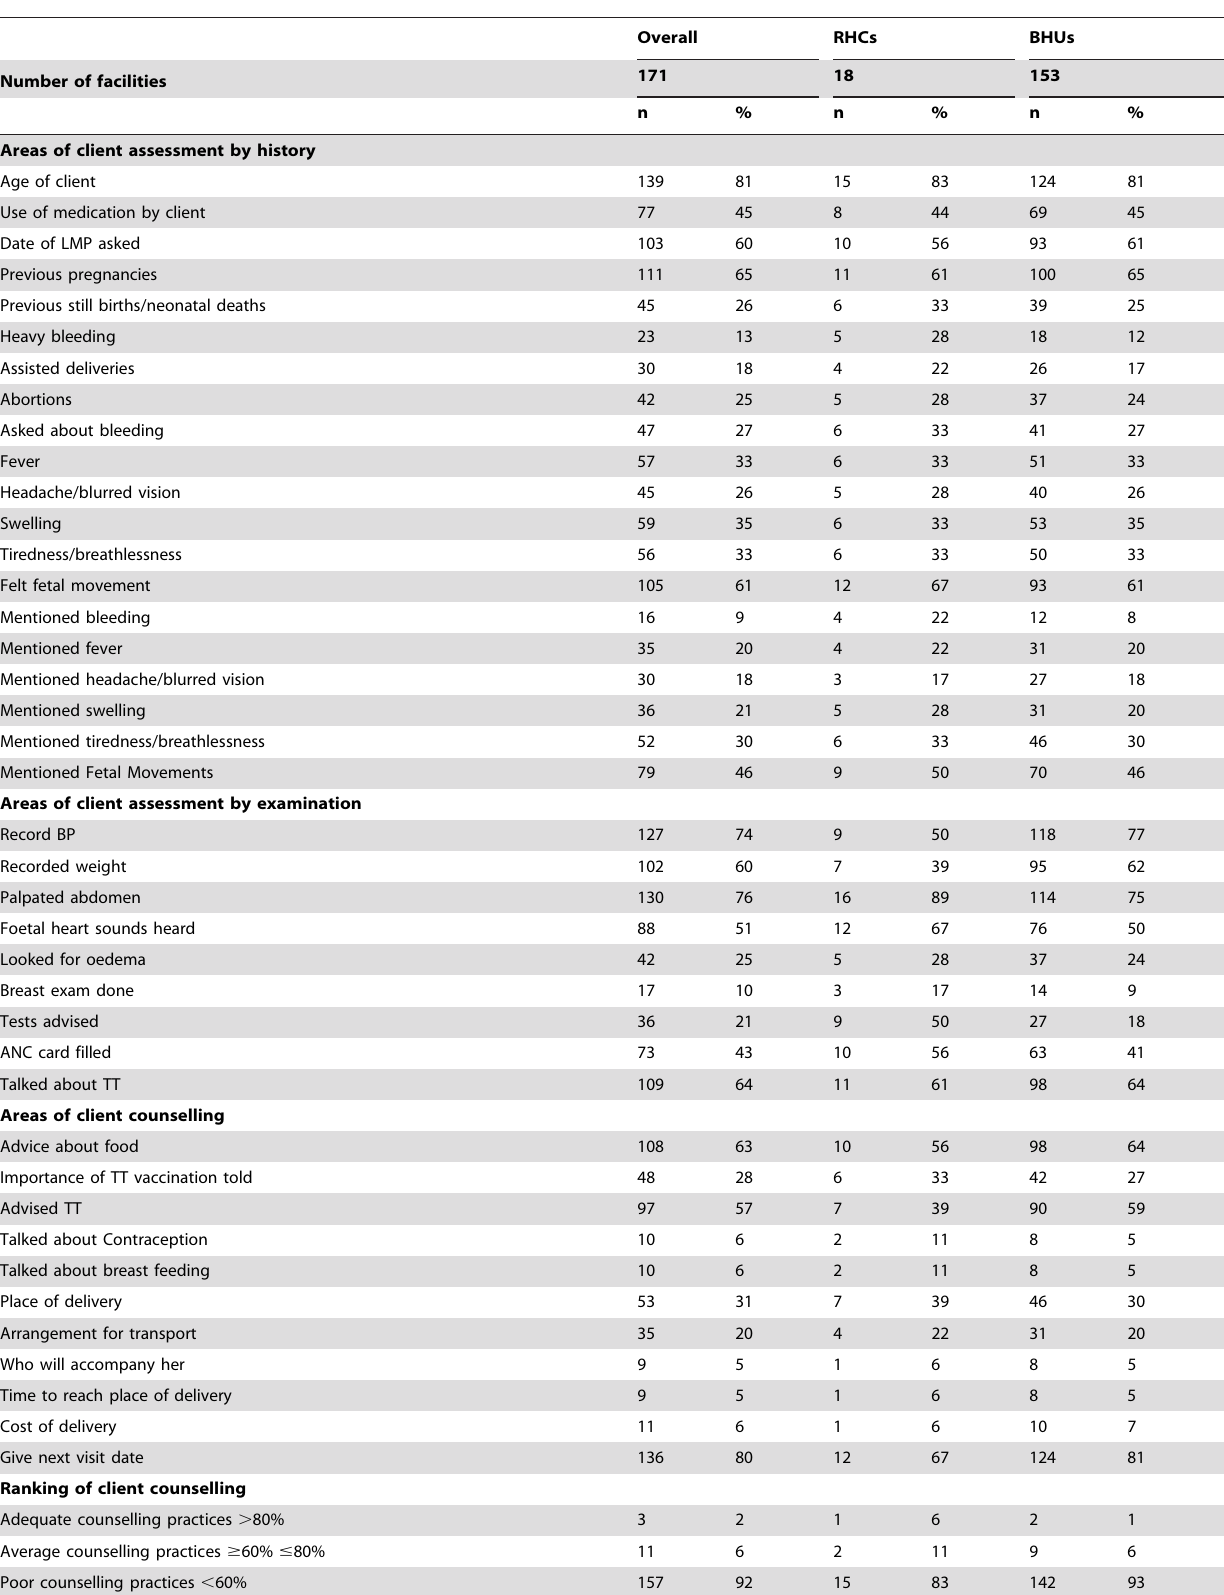
Table 2. Quality of ANC services and client satisfaction (Overall and by types of